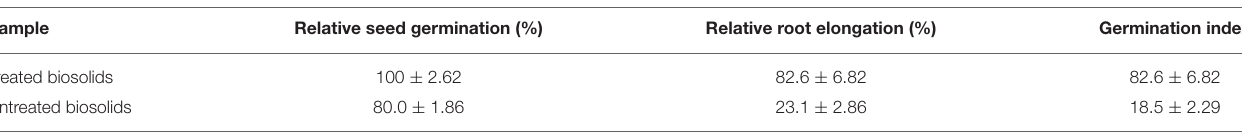
TABLE 1 | Seed germination tests in biosolid amended